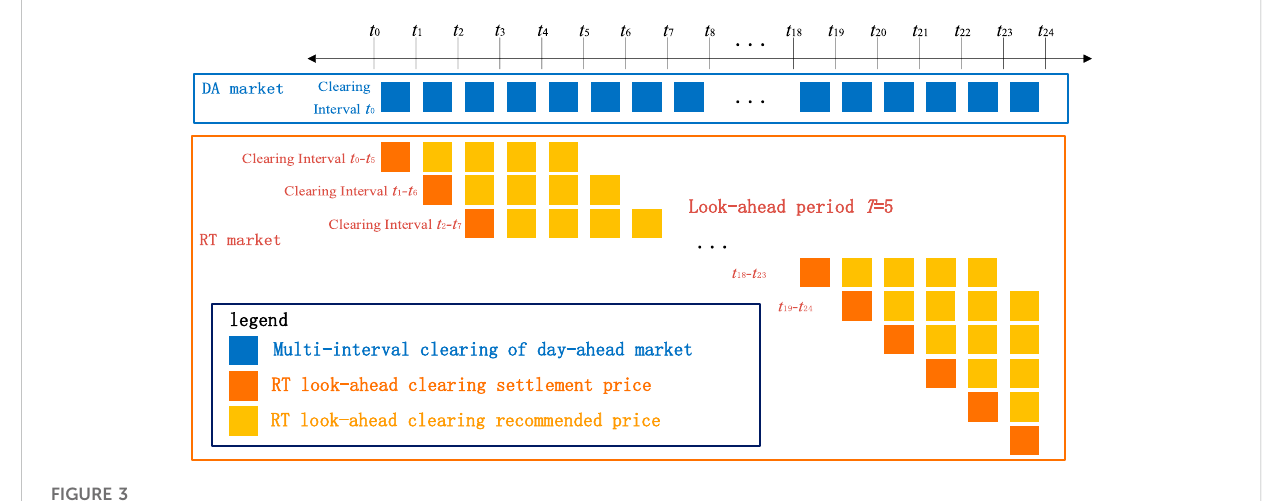
FIGURE 3 Look-ahead single-interval settlement.